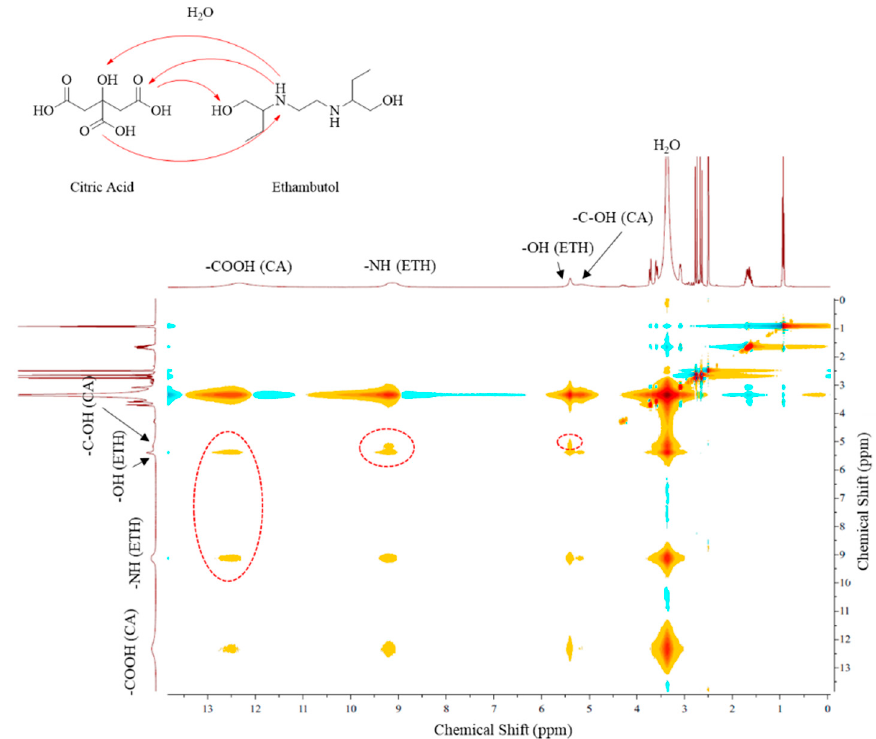
Figure 3. 1 H- 1 H–nuclear Overhauser enhancement spectroscopy (NOESY) with detected interactions between citric acid and ethambutol.